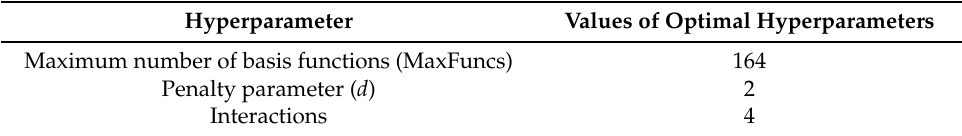
Table 3. Optimal hyperparameters of the best-fitted MARS model found with the ABC